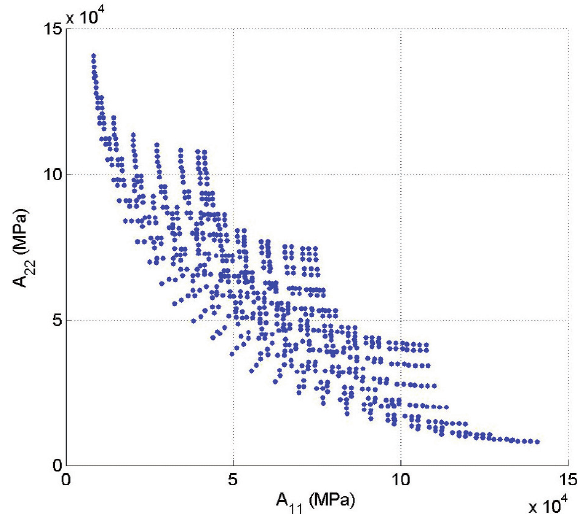
Fig. 5. Feasible domain in the case of a maximization of A11and A22 for 4 staking of 1 mm.